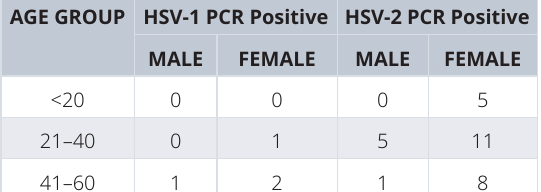
Table 2. Gender distribution of HSV-1 and HSV-2 positive sera using polymerase chain reaction